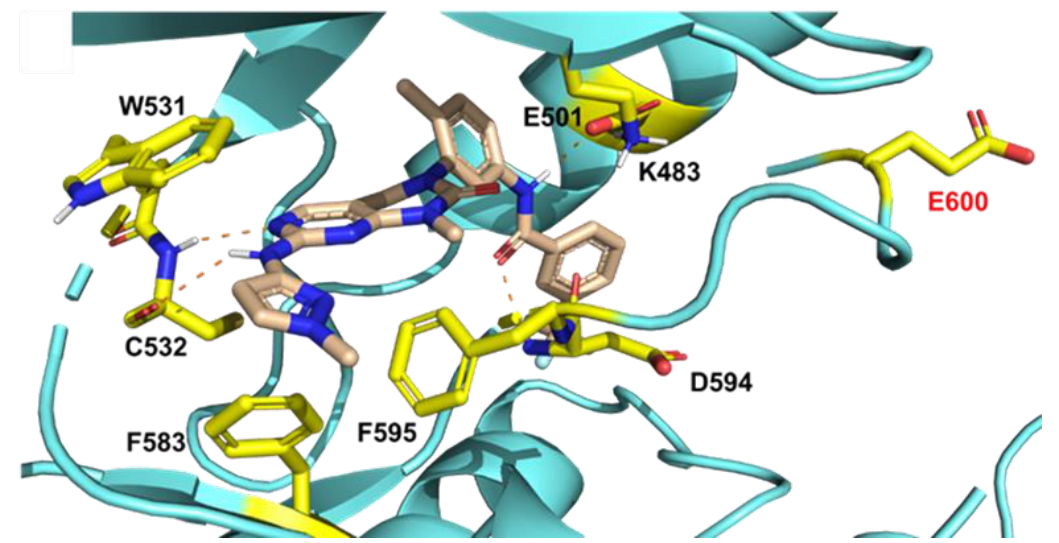
Figure 1. Docking model prediction of SIJ1777 on BRAF V600E mutant. H-bond interactions are indicated with dashed lines.